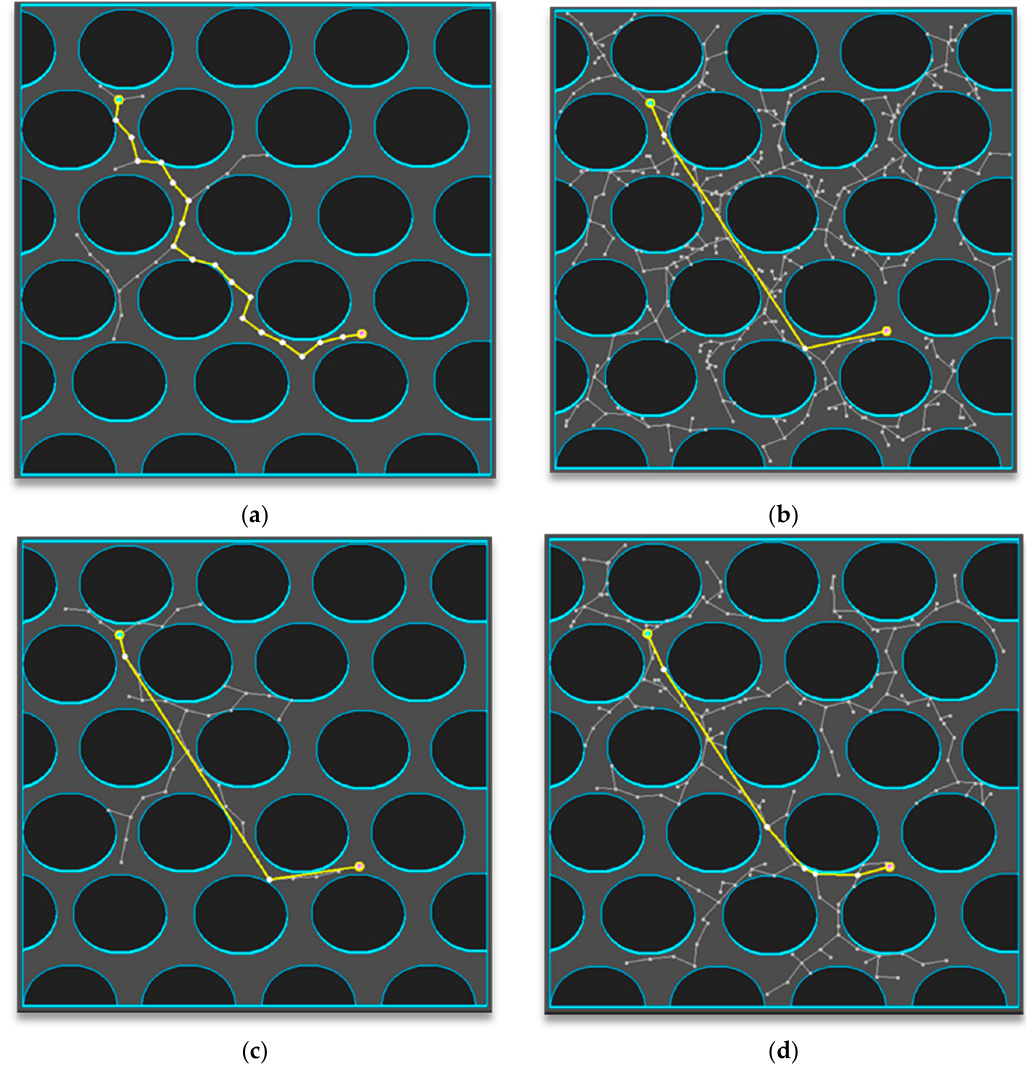
Figure 11. Experimental results of Map 3: ( a ) RRT; ( b ) Proposed method ( ε : 50 px) applied; ( c ) Proposed method ( ε : 30 px) applied; ( d ) Proposed method ( ε : 10 px) applied.